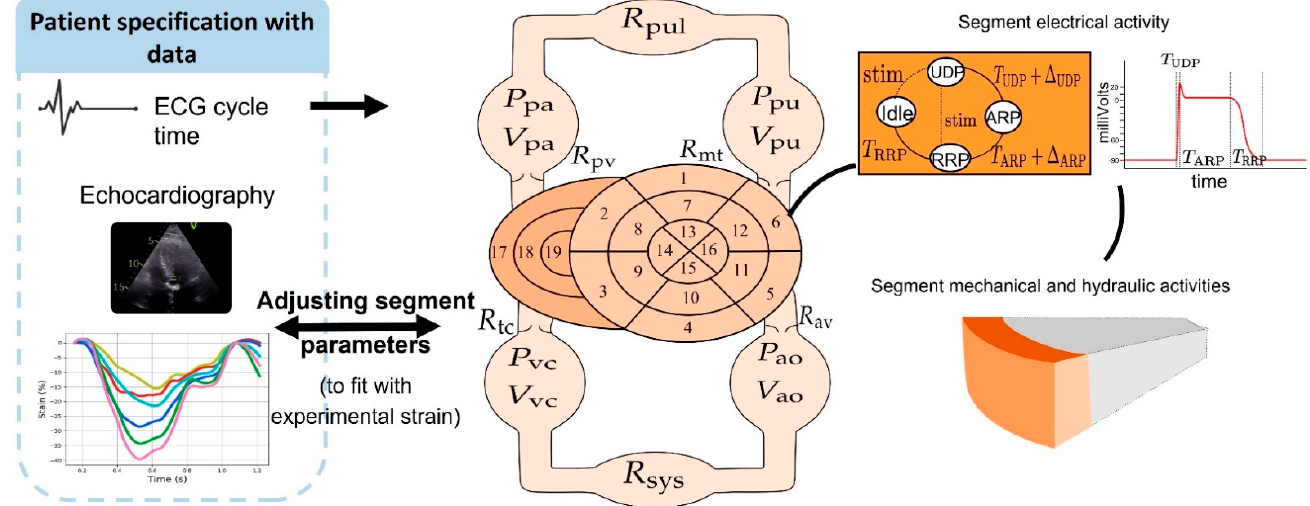
Figure 1. Exemplification of the exploitation of ECG and echocardiographic data obtained from pa- tients for the construction of an electro-mechanical heart model and characteristics of the model. Left panel: ECG cycle-time and strain-derived curves obtained from each patient were compared to the outputs of the model and used to adjust the model’s outputs to increase the patient’s specification of the model. Middle panel: Closed-loop model of the cardiovascular system including a multi-seg- ment representation of the left and right ventricles. Numbers (1 to 19) represent the different cardiac segments: (1) basal anterior; (2) basal anteroseptal; (3) basal inferoseptal; (4) basal inferior; (5) basal inferolateral; (6) basal anterolateral; (7) mid anterior; (8) mid anteroseptal; (9) mid inferoseptal; (10) mid inferior; (11) mid inferolateral; (12) mid anterolateral; (13) apical anterior; (14) apical septal; (15) apical inferior; (16) apical lateral; (17) right ventricular basal; (18) right ventricular median; (19) right ventricular apical. The systemic (sys) and pulmonary (pul) circulations include: aorta (ao), vena cava (vc), pulmonary artery (pa), and pulmonary veins (pu). Right panel: State diagram of the cellular automaton that shows the correspondence of the transition parameters with the myocardial action potential dynamic.